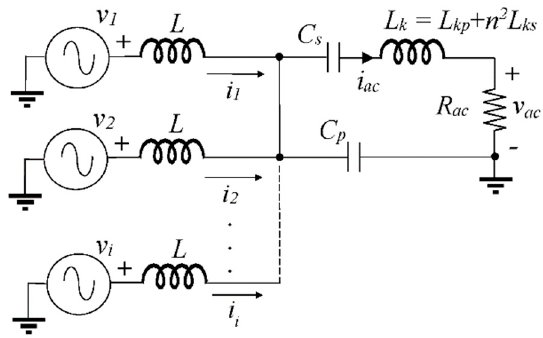
Figure 7. Simplified model using the fundamental approximation for circuit analysis purposes of the inverter stage.